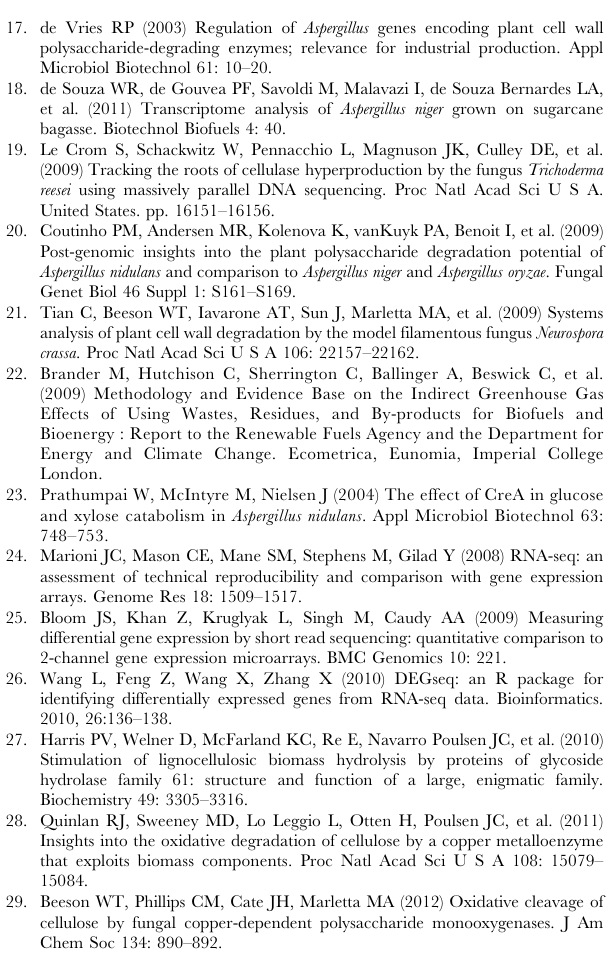
Table S1 Genes annotated in the CBS 513.8 genome but not the ATCC 1015 genome.